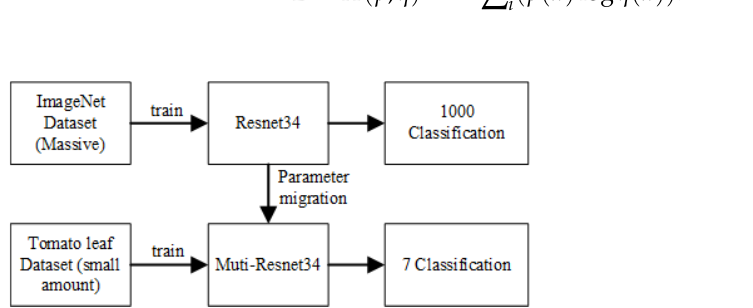
Figure 5. The training process of tomato disease image classification model based on transfer learn-